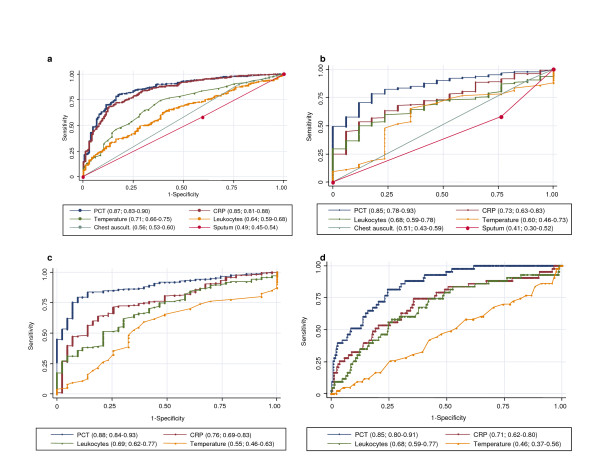
Receiver operating characteristics curves (ROC) of different parameters for the diagnosis of pneumonia. a diagnostic accuracy to predict CAP without chest radiography: Primary care approach. b diagnostic accuracy to predict radiographically suspected CAP (control group (n = 20) includes other non-infectious diagnoses initially diagnosed as CAP): Emergency department approach. c diagnostic accuracy to predict radiographically suspected CAP (control group (n = 44) includes other non-infectious diagnoses initially diagnosed as CAP (n = 20) plus patients without a clinically relevant bacterial etiology of CAP (n = 24). d diagnostic accuracy to predict bacteremic CAP. Values show areas under the ROC curve with 95% confidence intervals. Chest auscult. denotes abnormal chest auscultation; CRP C-reactive Protein; PCT procalcitonin.